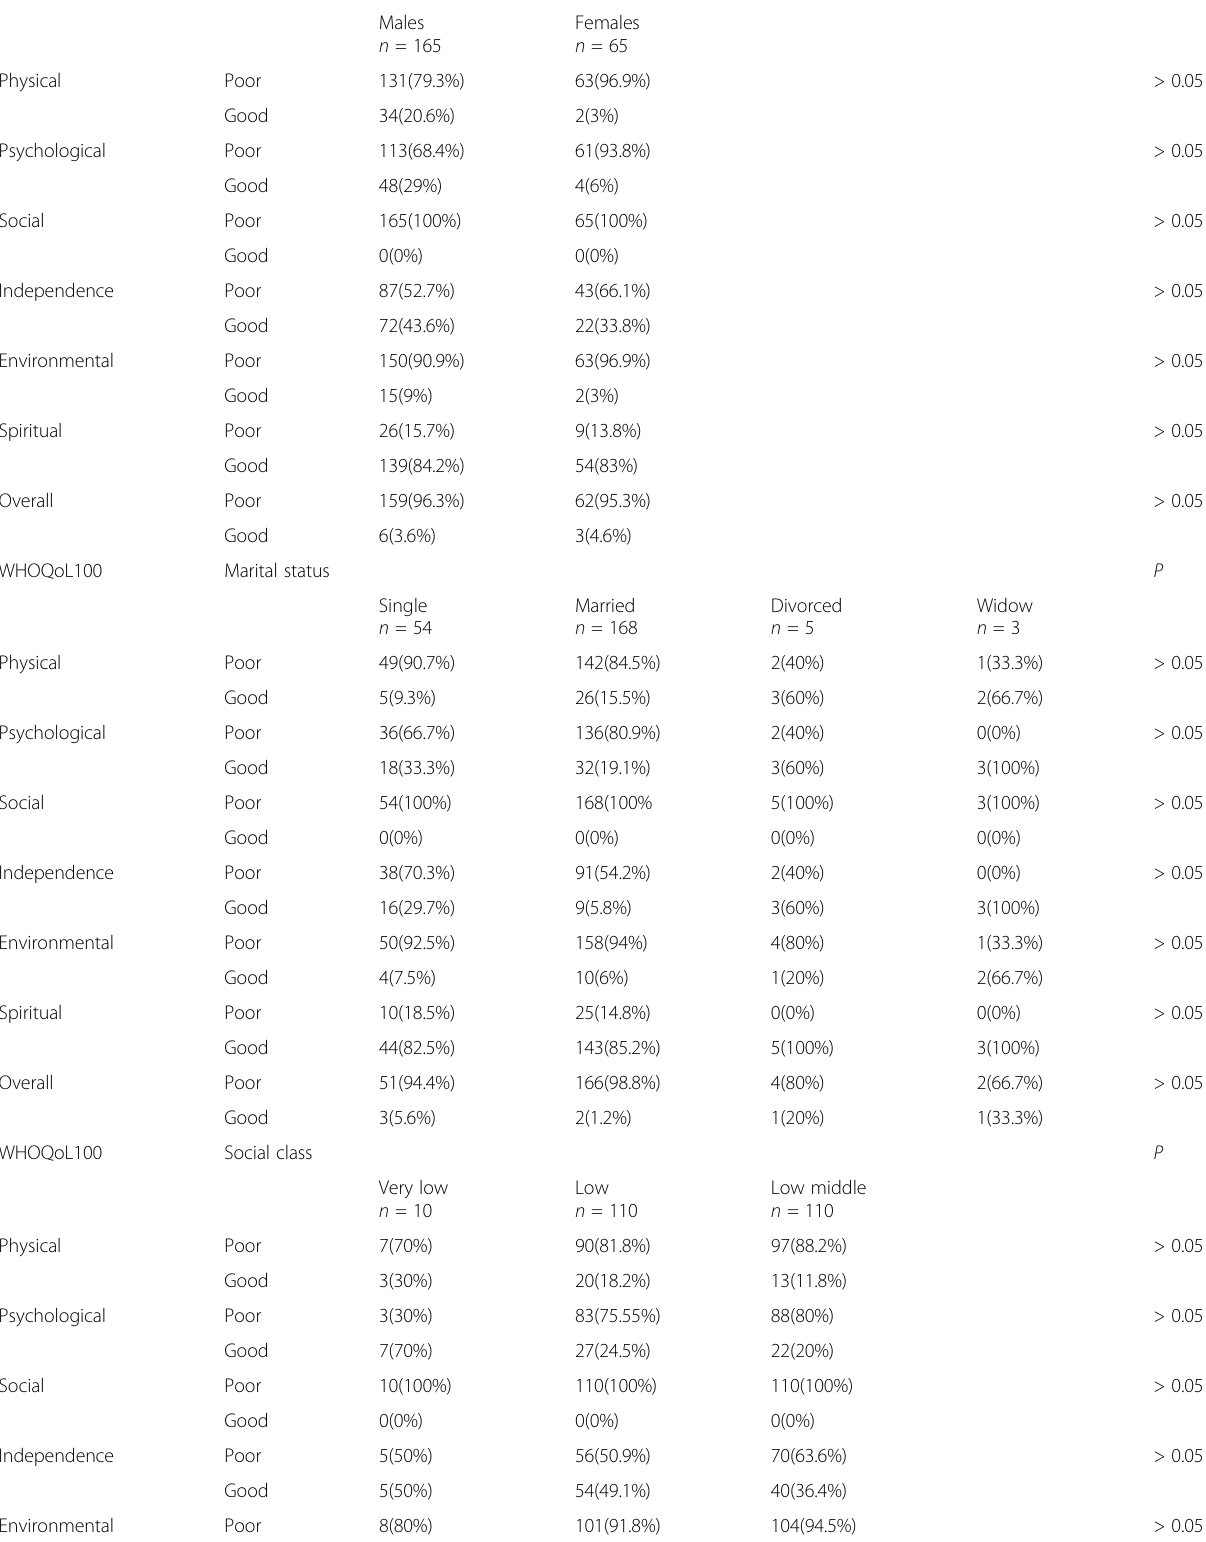
Table 1 Quality of life among PRTRs in relation to sex, marital status, and social class